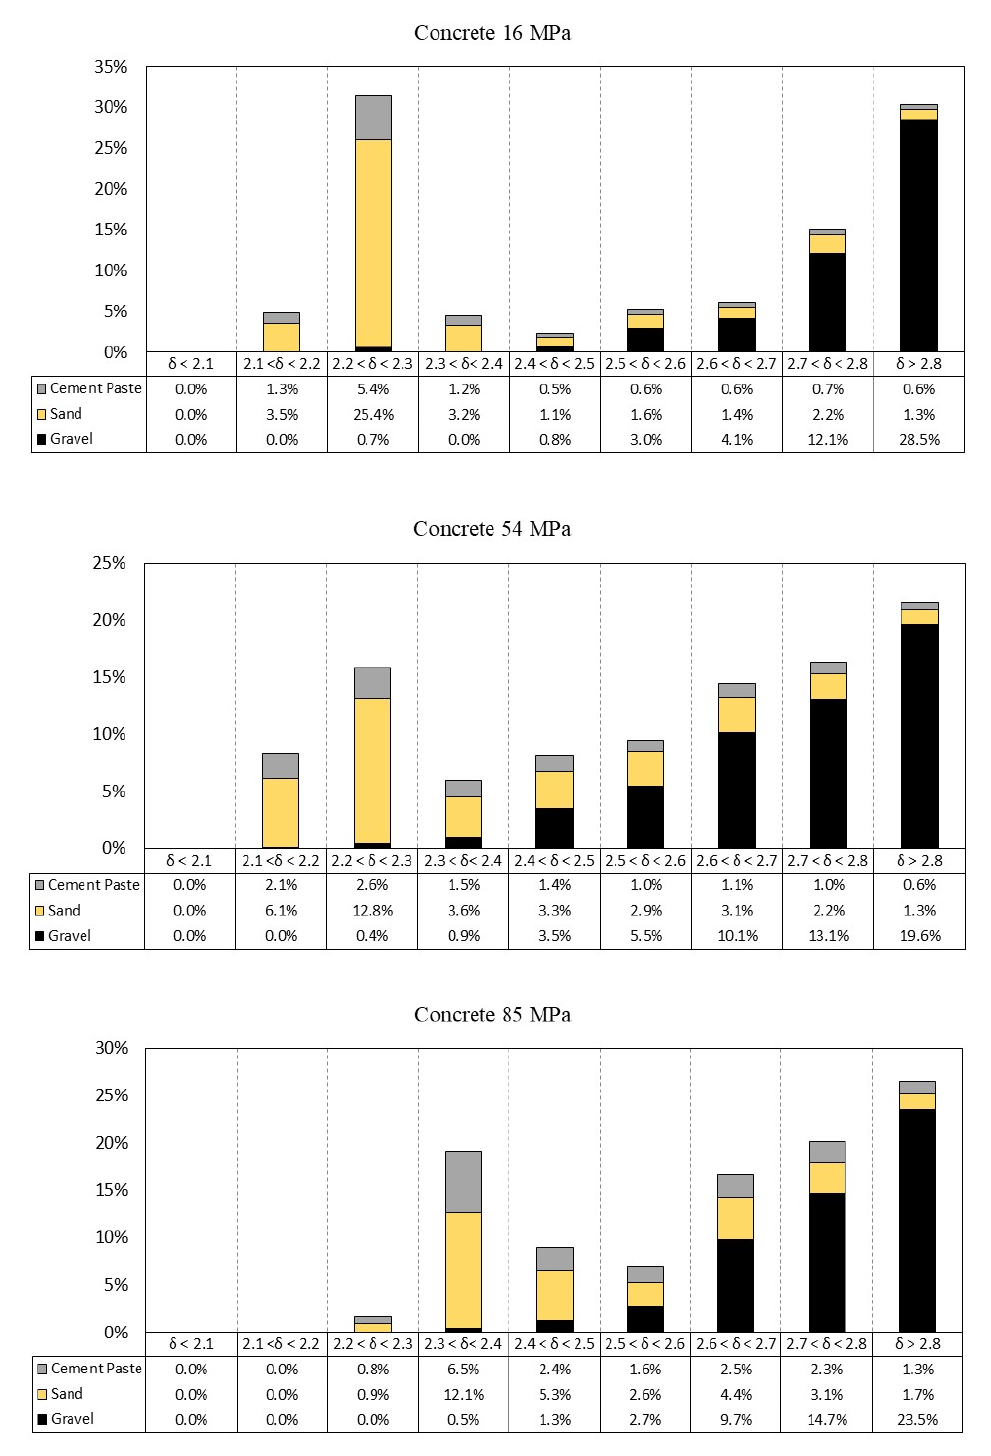
Figure 4. Cement paste, sand, and coarse aggregate content in different density fractions and concretes strengths. Concretes comminuted at 19.1 mm (size 4.75/19.1 mm).